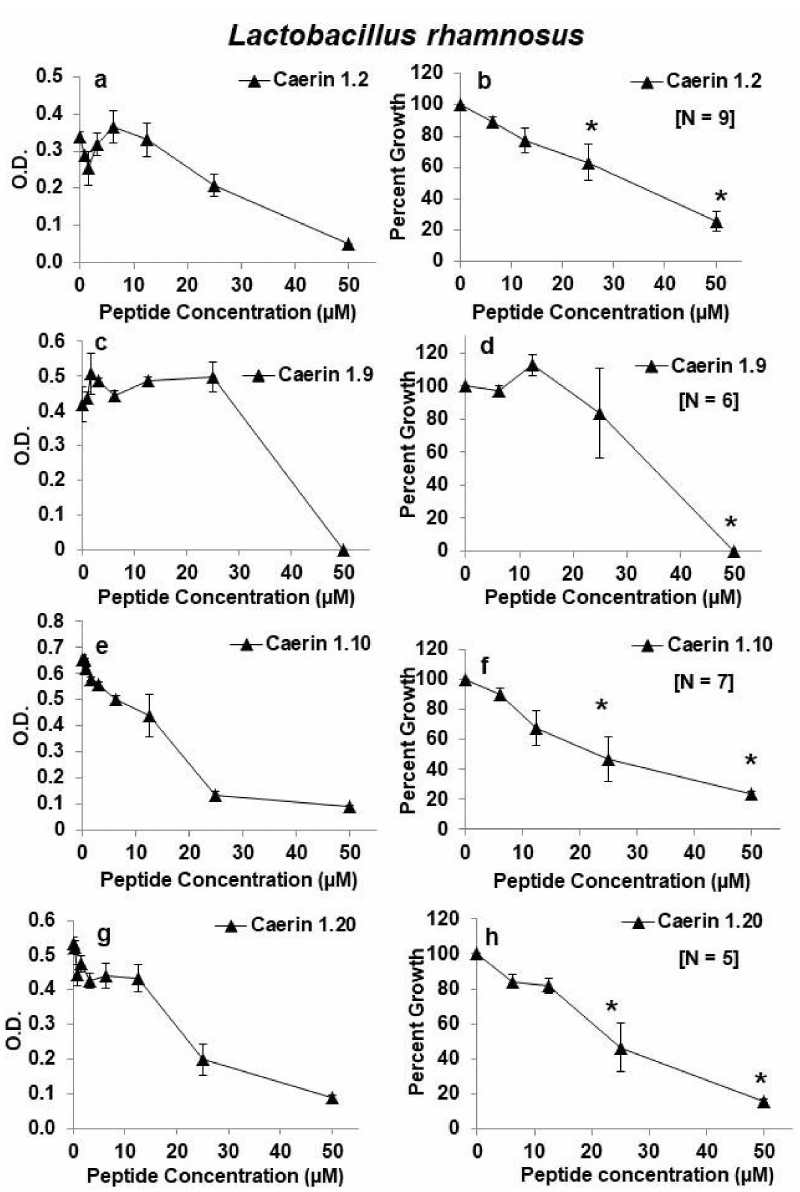
Figure 1. Effectsofcaerin1peptidesongrowthof Lactobacillusrhamnosus . ( a , b )Caerin1.2; ( c , d )Caerin1.9; ( e , f ) Caerin 1.10; ( g , h ) Caerin 1.20. Panels on the left show growth as changes in optical density (O.D.)